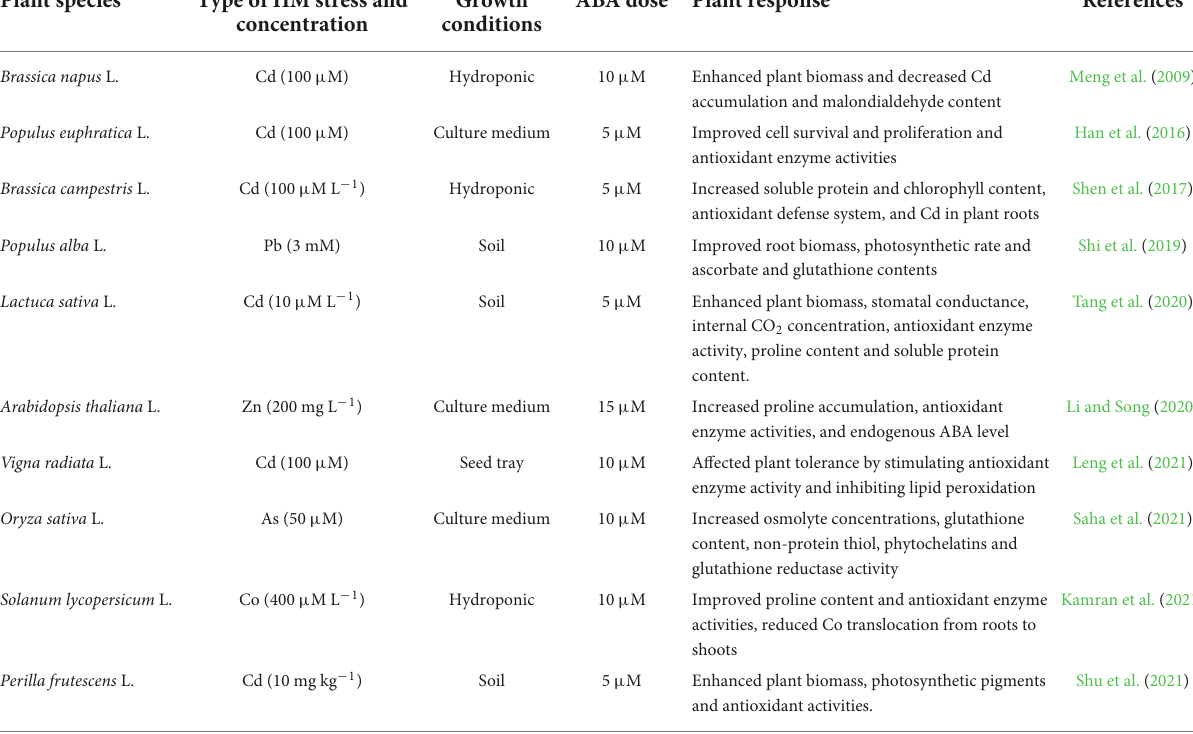
TABLE 2 Alleviation of heavy metal (HM) toxicity in plants by abscisic acid (ABA). Plant